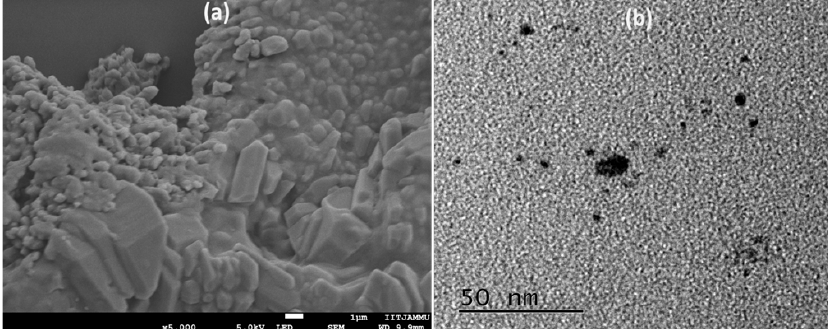
Figure 2. Morphology characterization of nanoemulsion analyzed using ( a ) SEM and ( b ) TEM.